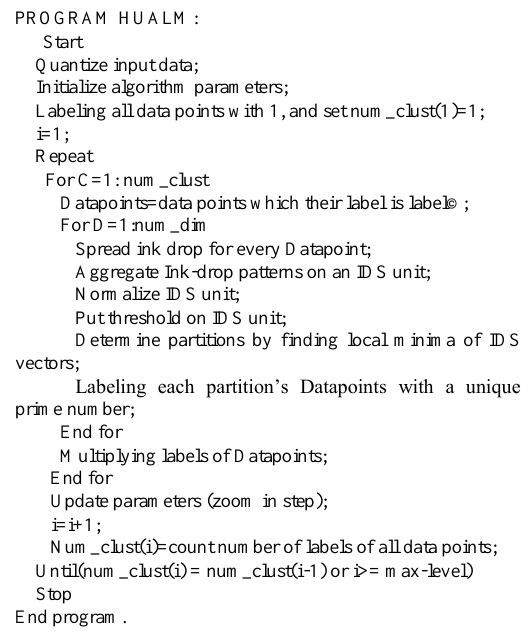
Figure 3.The pseudocode of HUALM